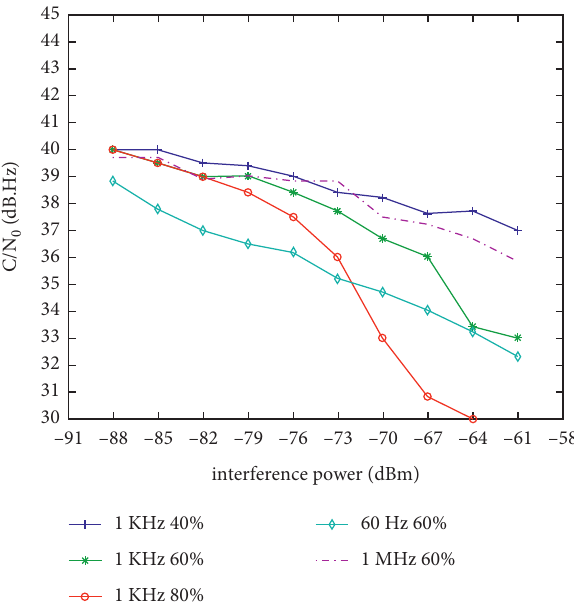
Figure 6: The C/N 0 in different pulse parameters